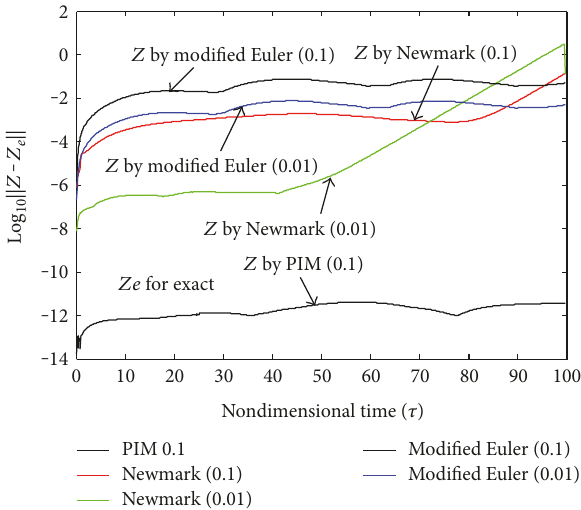
Figure 4: Logarithmic errors of modi fi ed Euler, Newmark, or PIM results with respect to the exact solutions of the aeroelastic system at U / U =0.9 in pitch 0